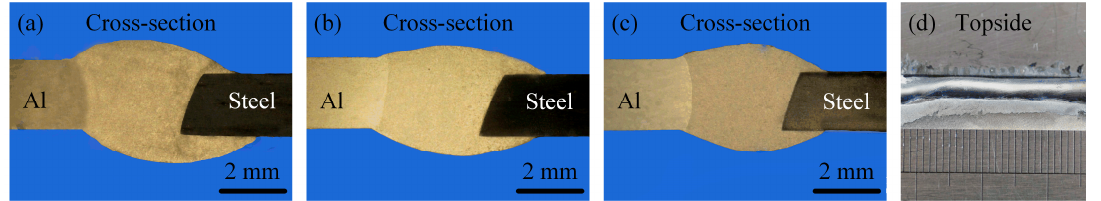
Figure 7. Effects of welding speed on the weld shape. ( a ) 0.8 m/min; ( b ) 1.0 m/min; ( c ) 1.2 m/min; ( d ) Figure 7. E ff ects of welding speed on the weld shape. ( a ) 0.8 m / min; ( b ) 1.0 m / min; ( c ) 1.2 m / min; 1.4 m/min.